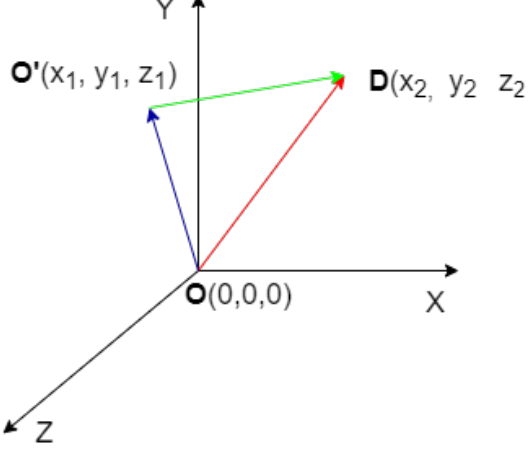
Figure 5. Representation of coordinate system in three-dimensional